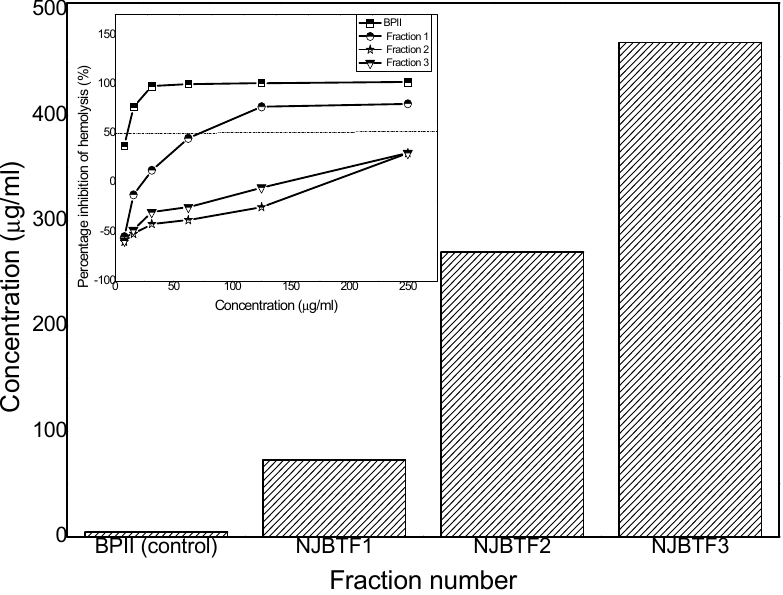
Figure 6. Dose-dependent activities of the C. moschata polysaccharide fractions (NJBTF1, 2, and 3) in the complement assay. BPII ( Biophytum petersianum ) was used as a positive control. Insert: includes the plot between percentage inhibition of hemolysis and concentration in µg for ICH 50 calculation of BPII and NJBTF1, 2, and 3.